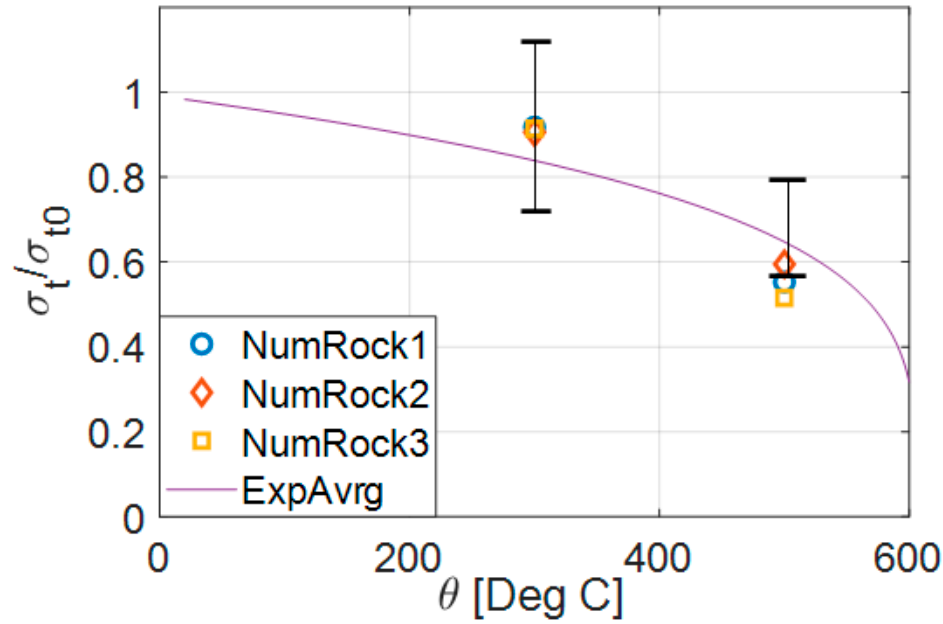
Figure 9. Normalized tensile strength vs. temperature predictions (experimental averaged curve and the variation at 300 ◦ C and 500 ◦ C for different granites are reproduced after the data in [11]).